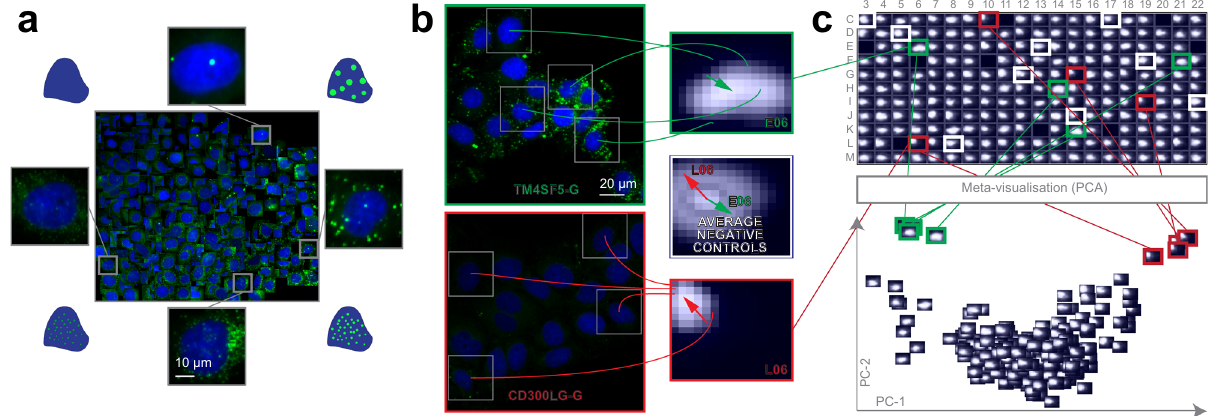
Fig. 2 Lipid droplet dataset. a Training set. Regression plane of 457 cells representing various lipid morphologies, created by an expert biologist. b RP output. Kernel Density Estimation (KDE)-maps of the predicted regression positions for cells treated with selected siRNAs. Arrows originate from the peak of the control KDE-map, and point to the peaks of the selected KDE-maps. c HCS analysis. Plate-based analysis performed by comparing well-based KDE- maps. Meta-visualization (in this case PCA – Principal Component Analysis) is obtained by extracting the principal components (PC1 and PC2) of the fl attened